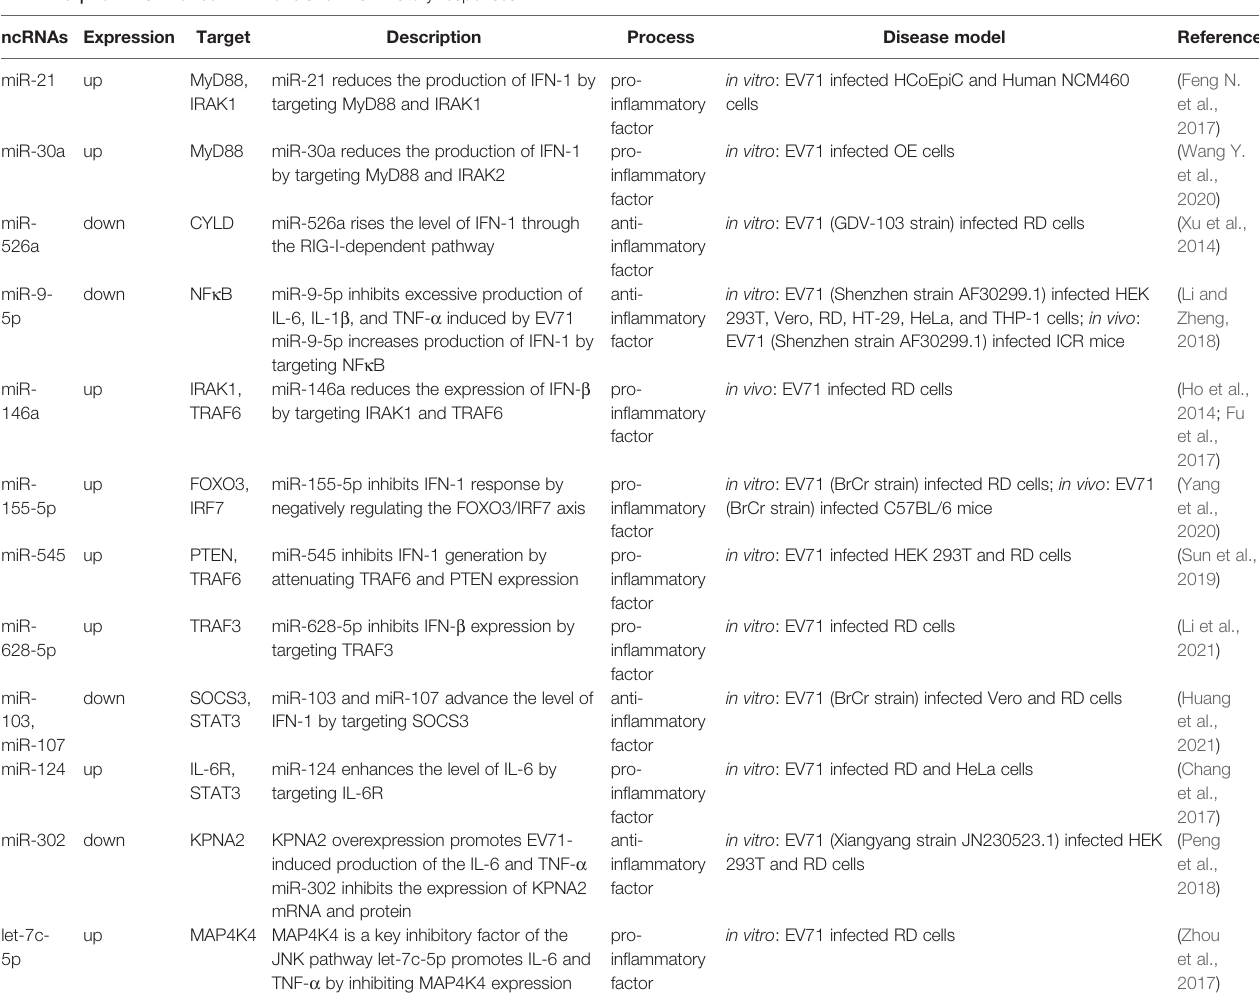
TABLE 3 | ncRNAs involved in immune and in fl ammatory responses. ncRNAs Expression